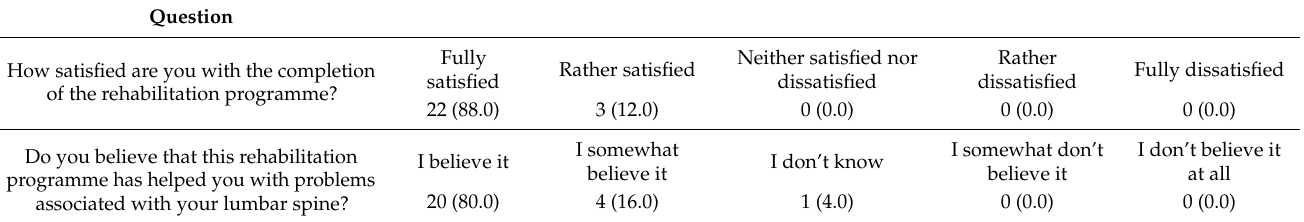
Table 3. Patient satisfaction with the rehabilitation programme and change in patient beliefs—Results.